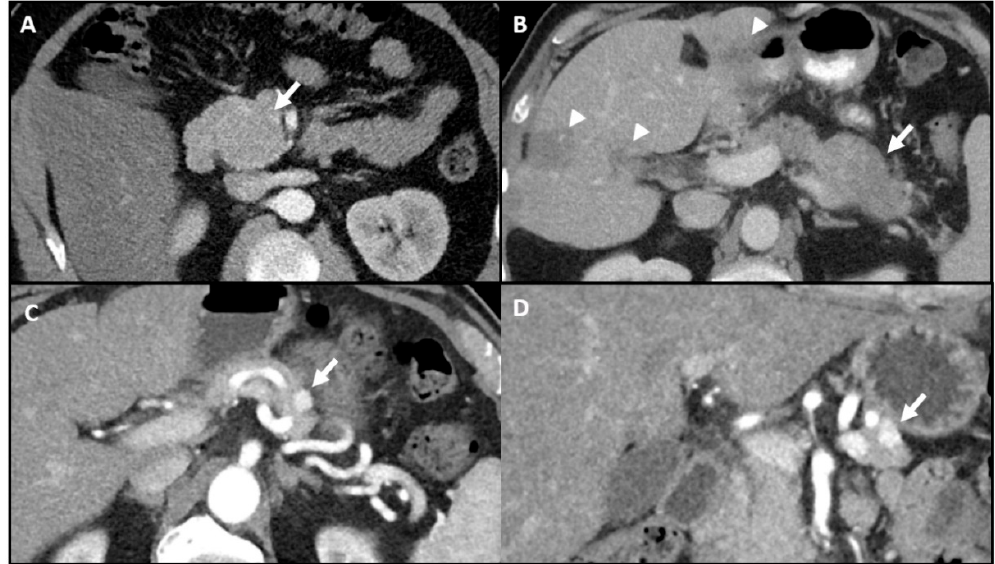
Figure 1. Variable appearance of pancreatic insulinomas on contrast-enhanced computed tomography (CT). ( A ) Axial image shows a 5.5 cm isodense insulinoma (arrow) in the uncinate process. ( B ) Axial image shows hypodense, malignant insulinoma within the pancreatic tail and liver metastases (arrowheads). ( C , D ) Axial and coronal images show an avidly enhancing 1.2 cm insulinoma in the pancreatic tail. All were proven to be pancreatic insulinomas by surgery or biopsy.